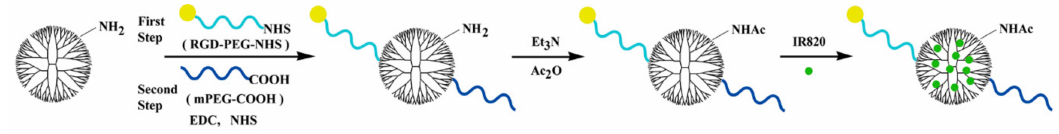
Figure 1. Schematic illustration of the synthesis of Ac-PR/IR820